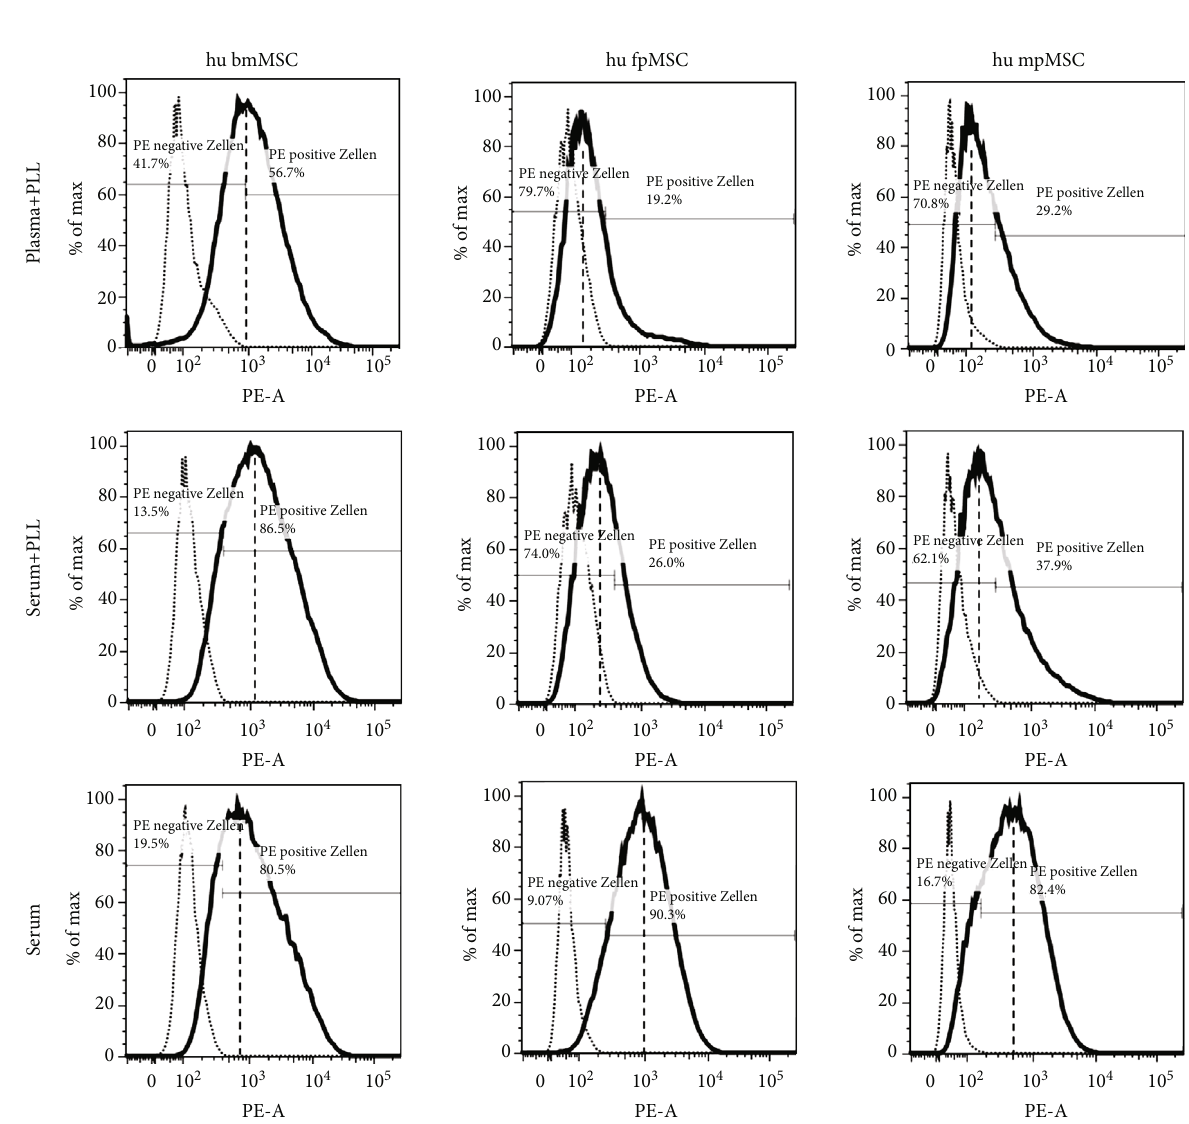
Figure 1: The expression of CD146 on bmMSCs and pMSCs. The bmMSCs, fpMSCs, or mpMSCs were expanded in GMP-compliant media complemented with plasma plus PLL, serum plus PLL, or serum as indicated. The expression of CD146 was determined by fl ow cytometry. While the CD146 expression did not di ff er among bmMSCs expanded in the di ff erent media, expansion of fpMSCs and mpMSCs in media complemented by PLL expressed less CD146 when compared to the same cells expanded in media complemented with serum but without